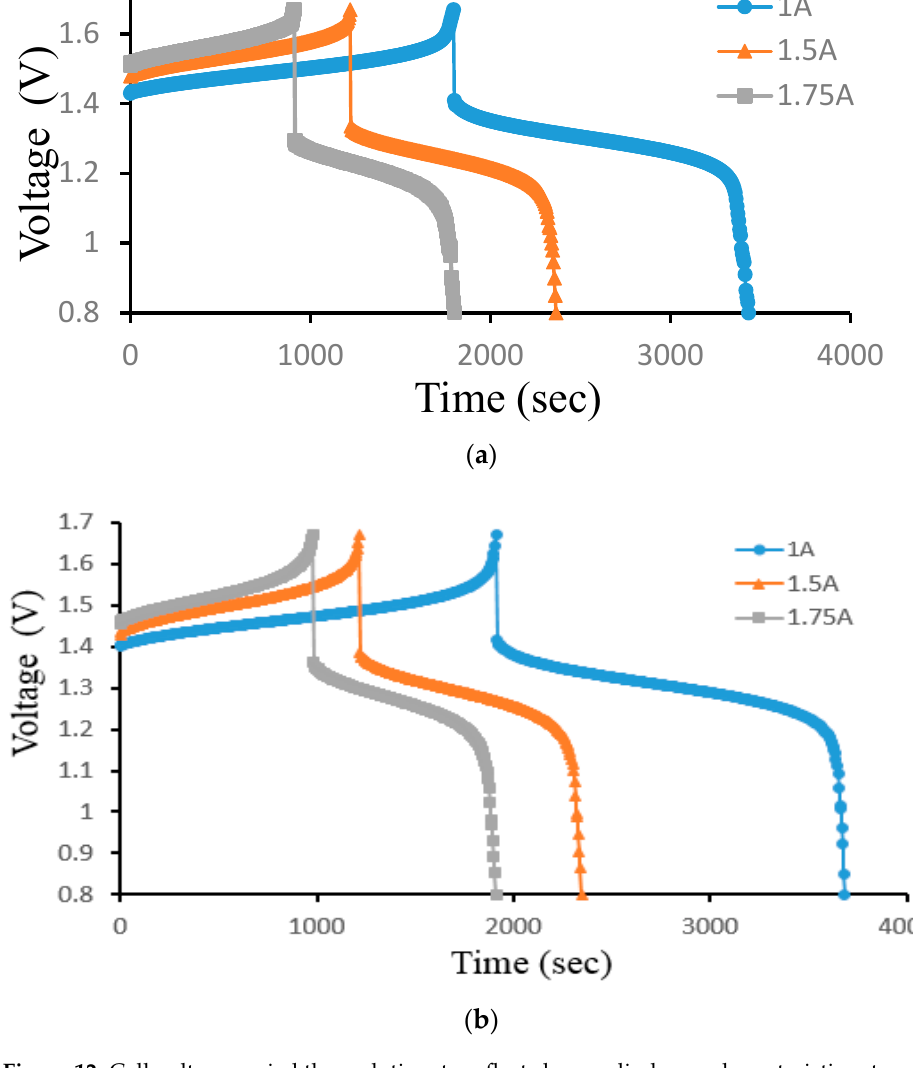
Figure 12. Cell voltage varied through time to reflect charge–discharge characteristics at controlled current density (40, 60, and 70 mA/cm 2 ) at a 300 mL/min flow rate for ( a ) smooth and ( b ) Case 4 from the experiment.